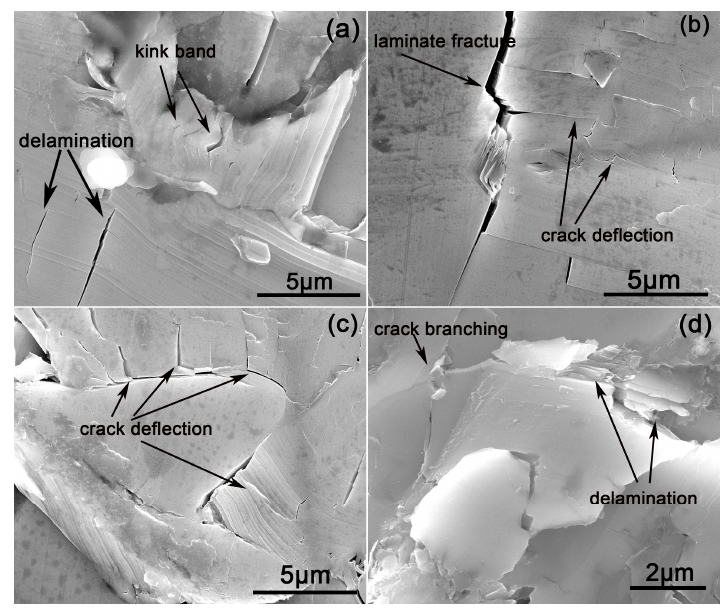
Figure 7. Indentation micrographs of the polished surfaces of the composites infiltrated by the Al–Si–xTi alloy (Si: 10 wt.%) with Ti contents (wt.%) of ( a ) 0, ( b ) 5, ( c ) 10, and ( d ) 15.